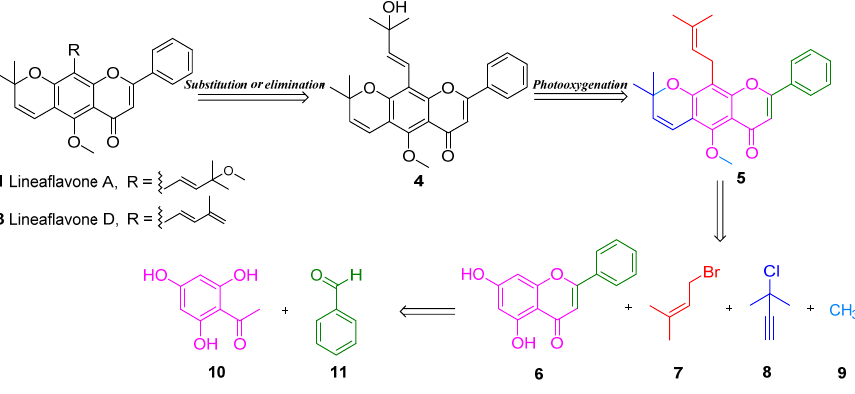
Figure 1. The structure of lineaflavone A, lineaflavone C and lineaflavone